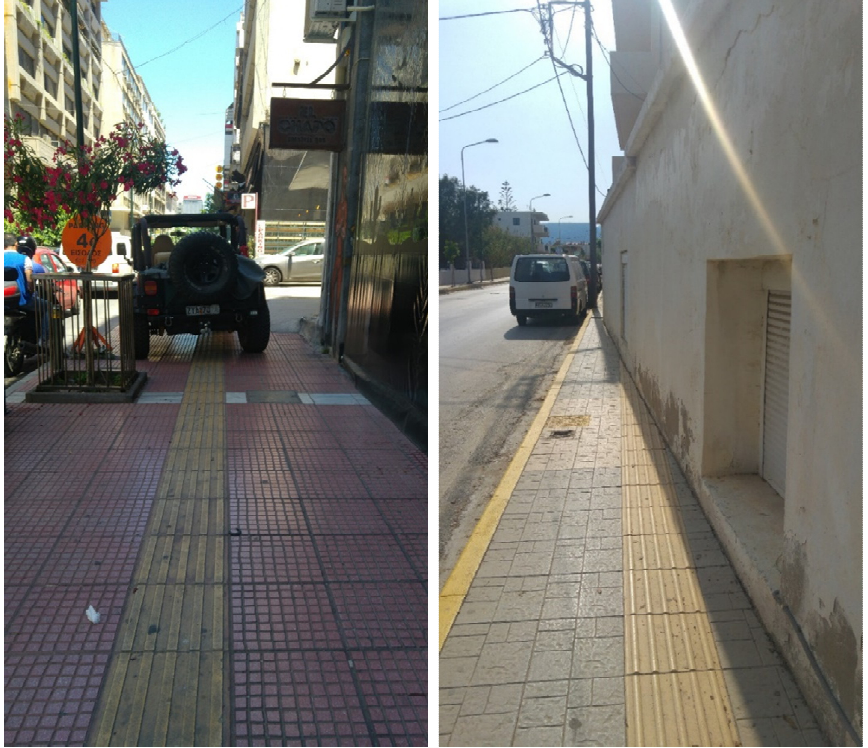
Figure 11. Obstacles difficult to